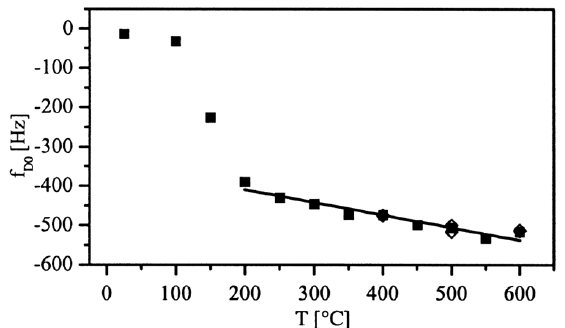
Figure 19. Frequency drop ( f temperatures and different atmospheric conditions (O by the Elsevier Science